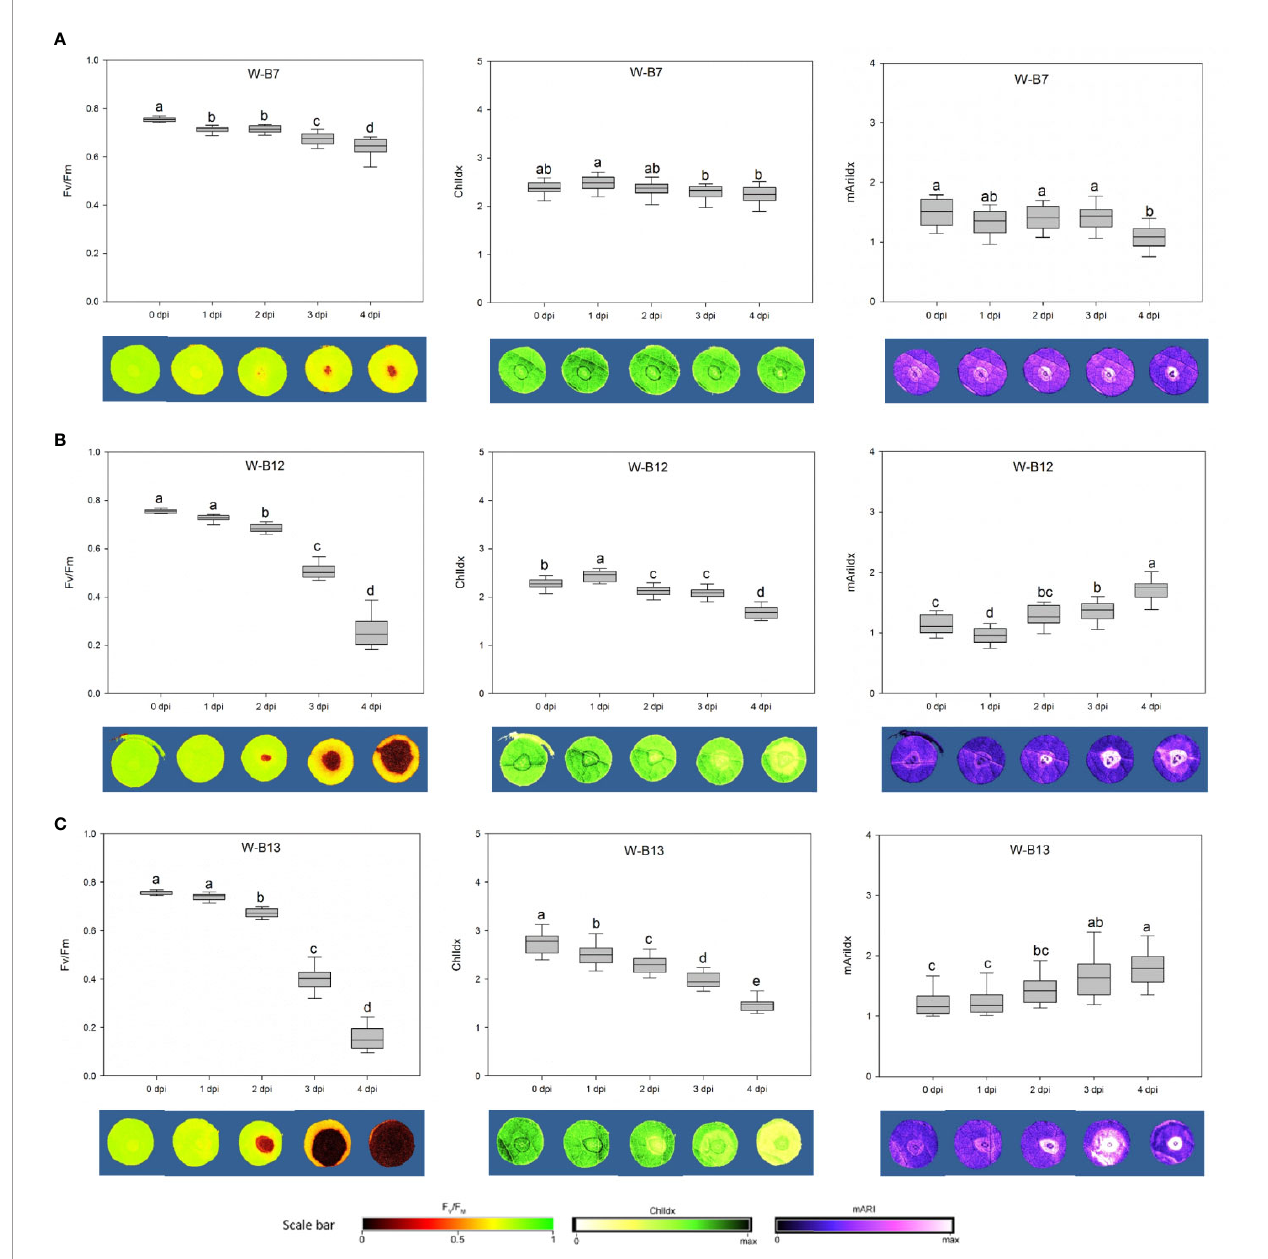
FIGURE 7 | The variations of F v /F m , ChlIdx, and mAriIdx from 0 to 4 dpi caused by Botrytis cinerea isolates B7 (A) , B12 (B) , and B13 (C) were correlated with the development of disease lesion on white-light-leaves. The corresponding images are presented underneath the fi gures. Disease lesion led to darker F v /F m image with lower value, yellower ChlIdx image with lower value, and brighter mAriIdx image with higher level. One-way ANOVA was applied for the statistical analysis (Tukey test, p ≤ 0.05), and data are shown by box plots with median. Different letters indicates signi fi cant differences among the time